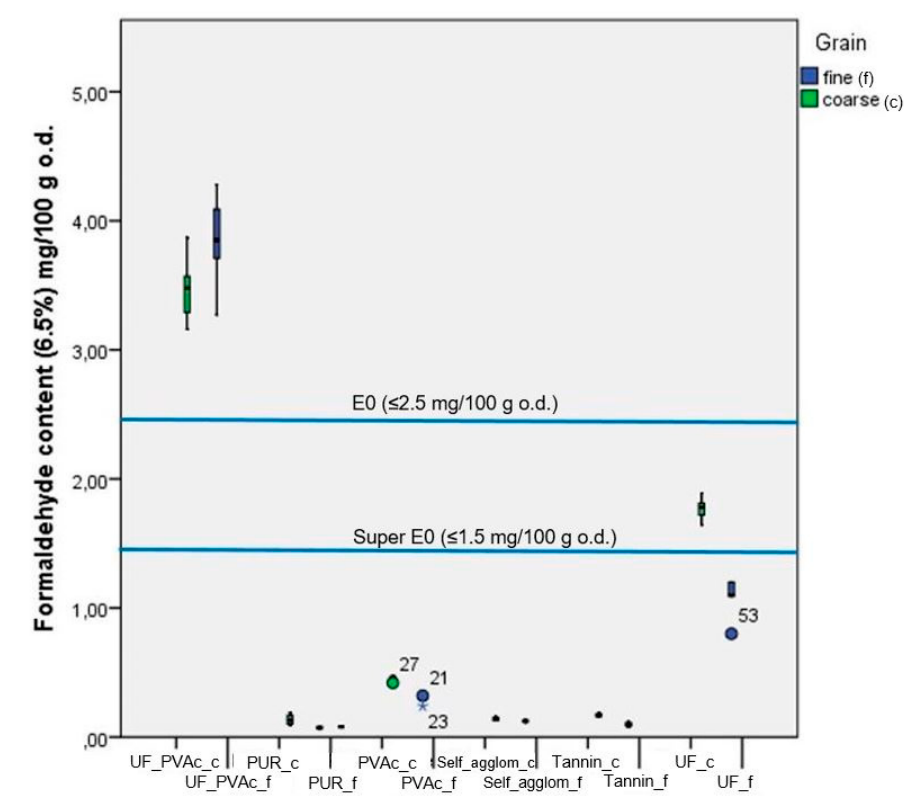
Figure 2. Free formaldehyde content measured according to EN 120:2011 of 10 mm larch-bark boards bonded with six types of adhesives.